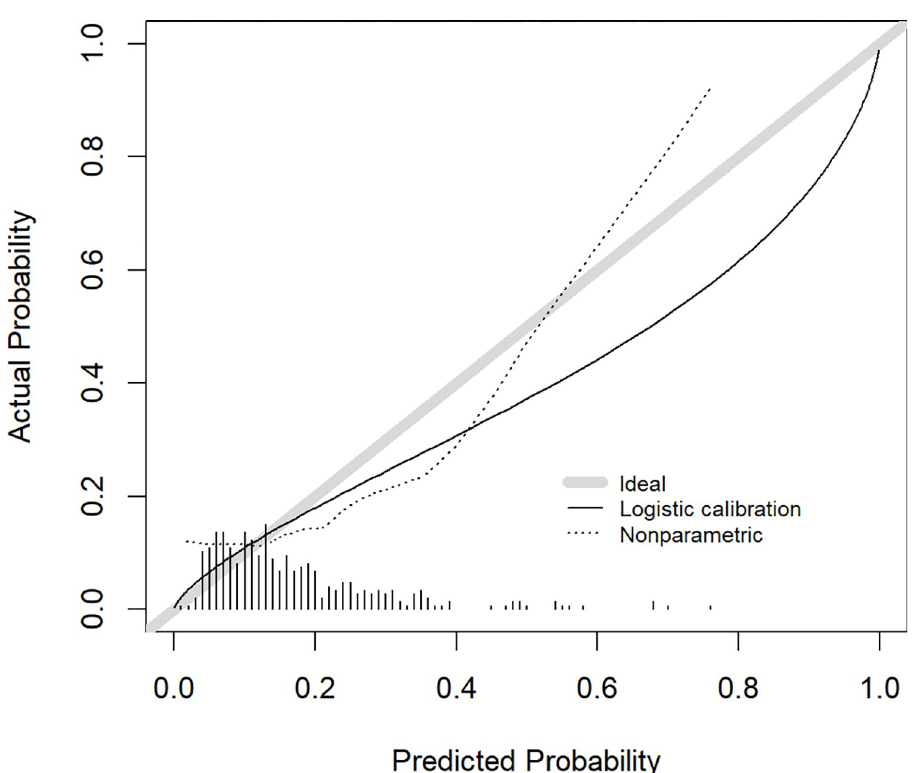
Fig 1. Calibration plot of actual versus the predicted probability in the external